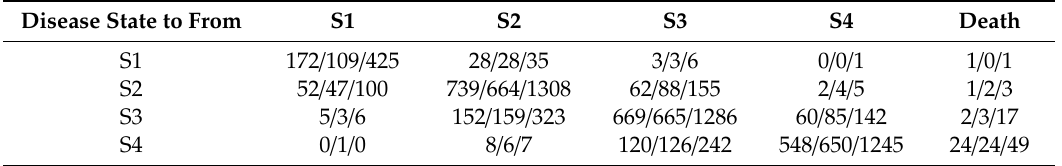
Table 4. Transitions of disease states observed during the first 15 days in the SepNet trials (MAXSEP / VISEP / Table 3. Transitions of disease states observed during the first five days in PROGRESS.